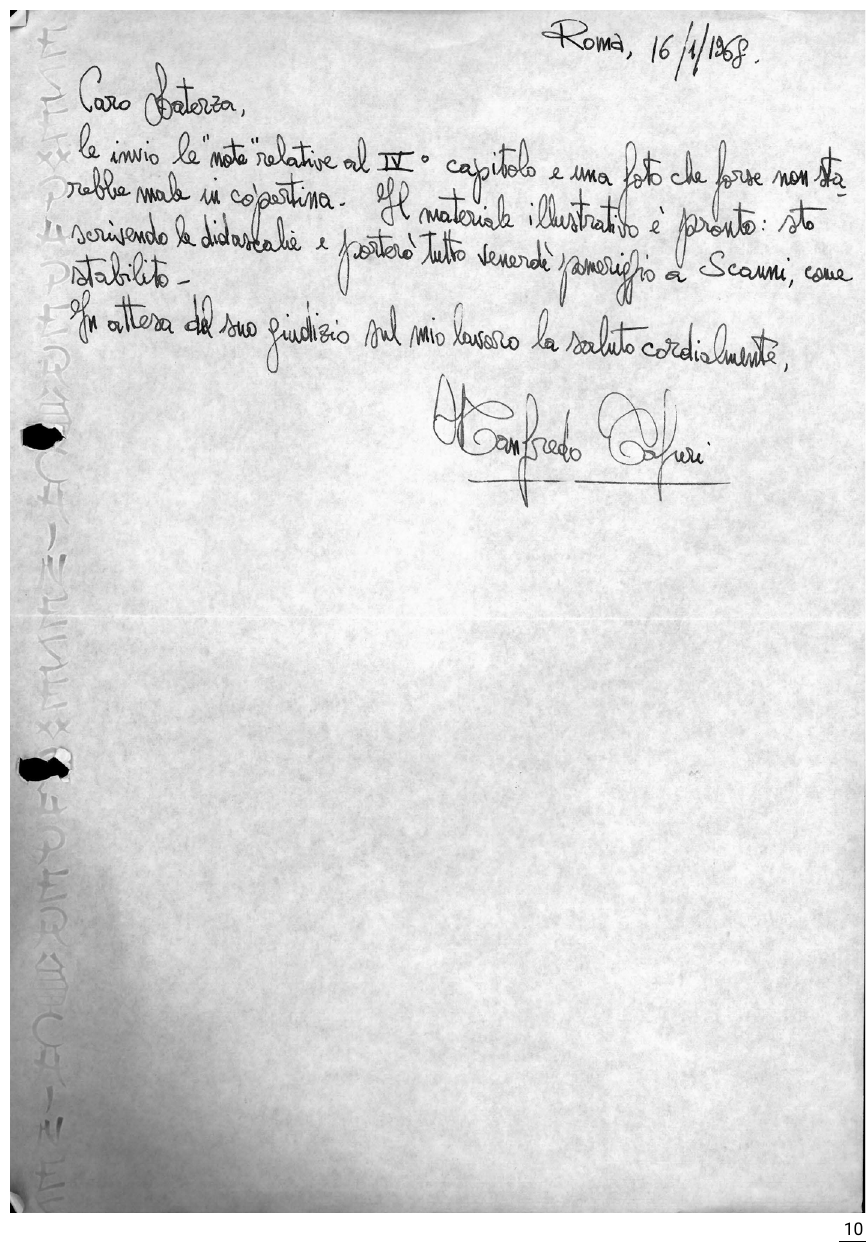
Manfredo Tafuri, handwritten letter to Vito Laterza.